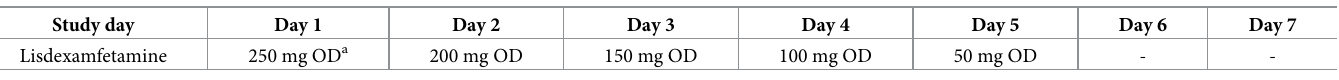
Table 2. Study drug dosing